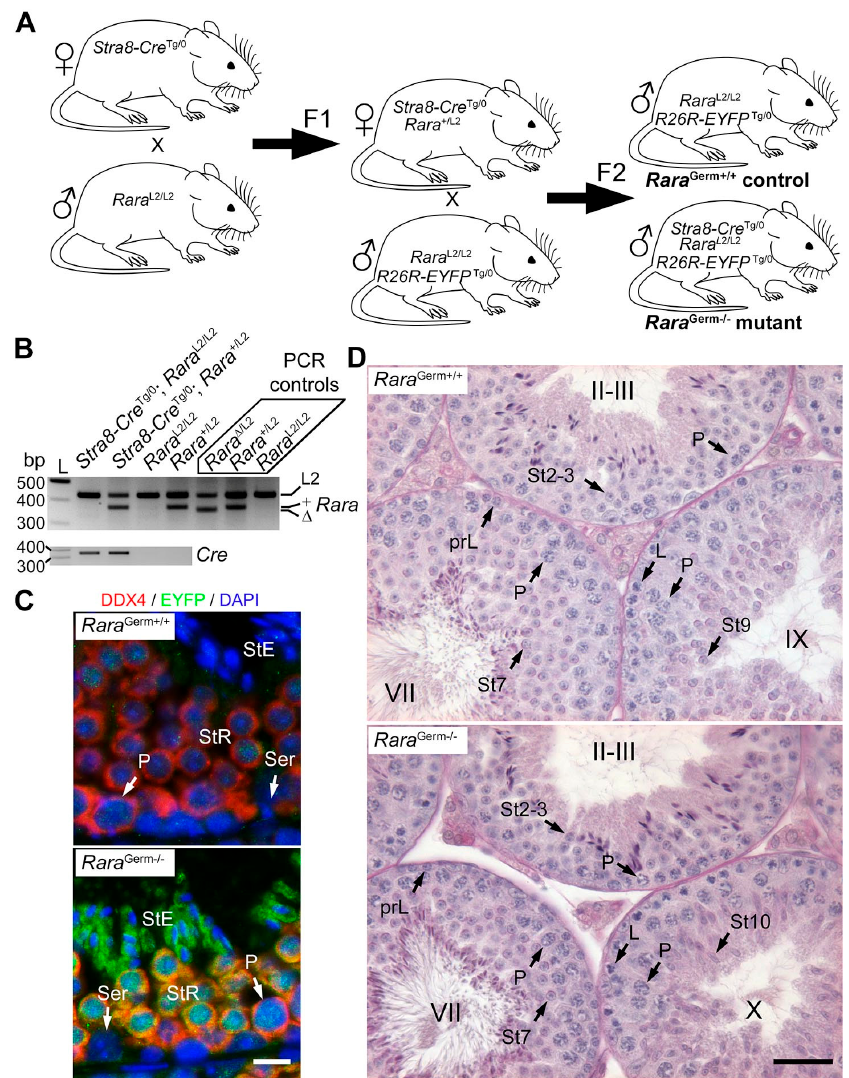
Figure 1. Rara Germ − / − mutants display normal spermatogenesis. ( A ) Breeding scheme. Stra8-Cre Tg/0 females were crossed with Rara L2/L2 males. This produced Stra8-Cre Tg/0 / Rara +/L2 F1 females, who were bred with Rara L2/L2 / R26R-EYFP Tg/0 males to produce control ( Rara Germ+/+ ) and mutant ( Rara Germ − / − ) mice in F2. ( B ) Representative PCR analysis of tail DNA from F2 males with the genotype as indicated. The 427-, 371-, and 357-bp-long fragments correspond to floxed (L2), wild-type (+), and excised ( ∆ ) alleles of the Rara gene, respectively (upper panel). Rara ∆ /L2 , Rara +/L2 , and Rara L2/L2 were used as PCR controls, as indicated. Note that the ∆ allele of Rara is absent from the F2 progeny, as expected (upper panel). The 350-bp-long fragment corresponds to the Tg(Stra8-cre)1Reb transgene ( Cre , lower panel). L: ladder; bp: base pair. ( C ) Detection of DDX4 (red signal) and EYFP (green signal) on histological sections of testes from 3-month-old control ( Rara Germ+/+ ) and mutant ( Rara Germ − / − ) mice bearing the reporter transgene. Nuclei were counterstained with DAPI (blue signal). In the control testis, EYFP was not detected (upper panel). In the mutant testis, EYFP was detected in all pachytene spermato- cytes and spermatids, but not in Sertoli cells (lower panel). This illustrates efficient Cre-mediated excision in mutant mice. ( D ) PAS stains illustrating normal germ cell associations in the seminifer- ous epithelium of 3-month-old control ( Rara Germ+/+ ) and mutant ( Rara Germ − / − ) testes, as indicated. Leg- end: prL, L, and P, preleptotene, leptotene, and pachytene spermatocytes, respectively; Ser, Sertoli cell; St2–3 to St10, steps 2–3 to step 10 of spermatid maturation; StE, elongated spermatid; StR, round spermatid; II–III, VII, IX, and X, epithelial stages. Scale bar: 10 μ m in ( C ); 70 μ m in ( D ).